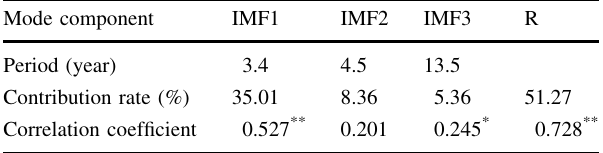
Table 3 The variance contribution rate and correlation coefficient of each component of the standardized precipitation evapotranspiration index (SPEI) series in the Heihe River Basin during 1961–2014 Mode